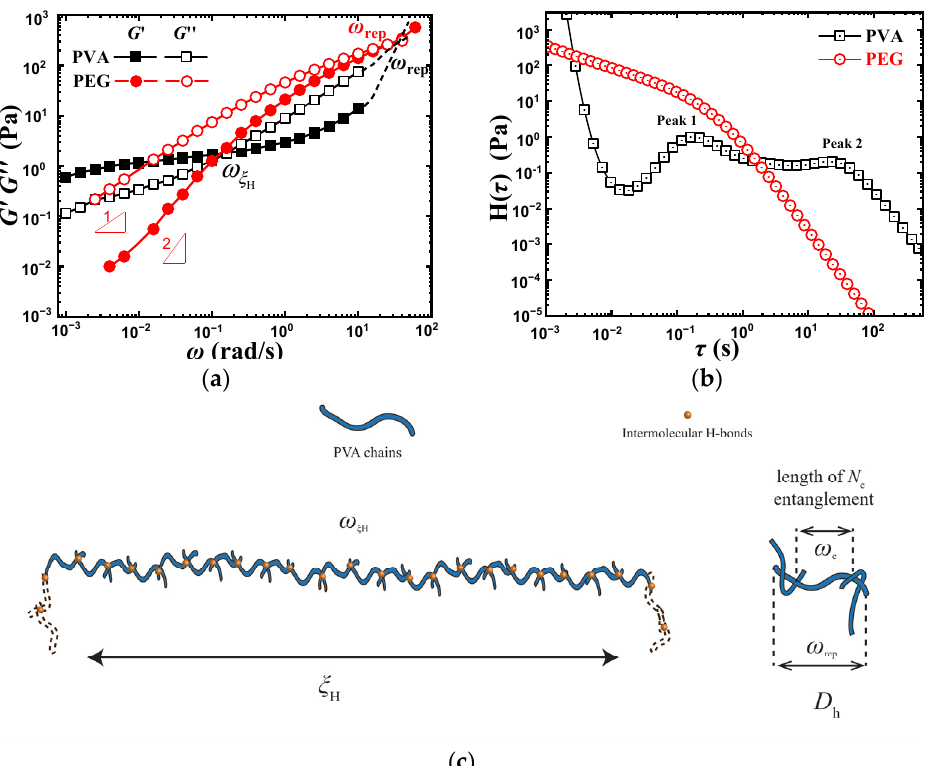
Figure 4. Dynamic test result and the corresponding relaxation spectrum of 10 wt% PVA and 10 wt% PEG solution. ( a ) Dynamic rheological behavior. ( b ) Relaxation spectrum. ( c ) Schematic diagram of relaxation units at ω ξ , ω rep and ω e